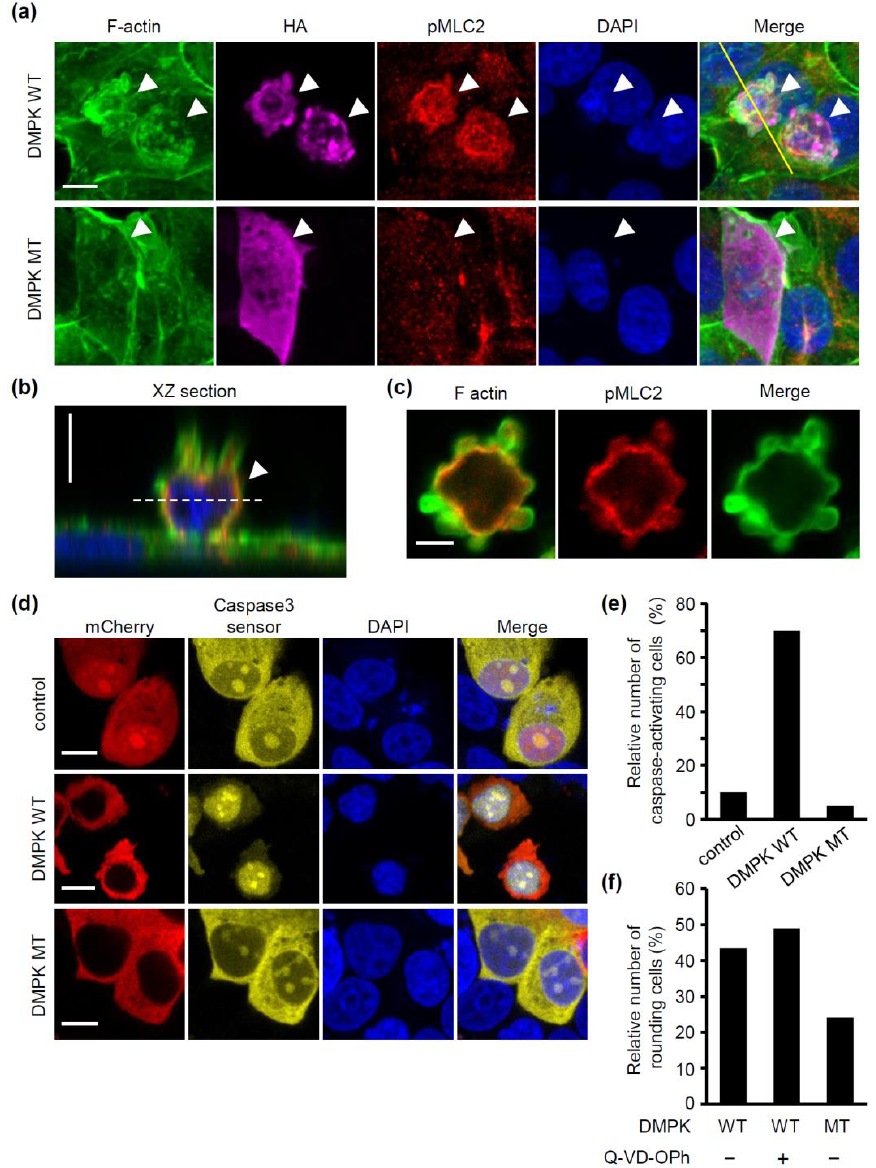
Figure 5. Overexpression of DMPK induces caspase activation in a kinase activity dependent manner. ( a – c ) MCF-7 cells were transfected with expression plasmid for HA-DMPK-wild-type (WT) or HA-DMPK-kinase dead mutant (MT). Confocal images of cells stained for F-actin using phalloidin (green), HA (purple), pMLC2 (red) and DNA using DAPI (blue). ( a ) Z-stack images with 25 slices at 1.0 µ m intervals were obtained. The projected images are shown. Arrowheads indicate DMPK WT or MT overexpressing cells. Scale bar is 10 µ m. ( b ) XZ section image along the yellow line of a cell expressing HA-DMPK-WT in figure a is shown. Image for HA staining is omitted for clarity. Scale bar is 10 µ m. ( c ) XY section images along the white dots line of a cell expressing HA-DMPK-WT in figure b are shown. Image for DAPI is omitted for clarity. Scale bar is 5 µ m. ( d , e ) Cells were co-transfected with EYFP-Caspase-3 sensor and mCherry (control), mCherry-DMPK-WT or mCherry-DMPK-MT. ( d ) Confocal images of MCF-7 cells stained for mCherry (red), Caspase-3 sensor (yellow) and DNA using DAPI (blue). Z-stack images with three slices at 1.0 µ m intervals of the middle of cells were obtained. The projected images are shown. Scale bar is 10 µ m. ( e ) Relative number of caspase-activating cells are shown (n = 20). ( f ) Cells were transfected with mCherry-DMPK-WT or mCherry-DMPK-MT. After 6 h, cells were treated with Q-VD-OPh (100 µ M) for 30 h. Z-stack images with an interval of 3.0 µ m were obtained. The relative number of rounding cells are shown (n =